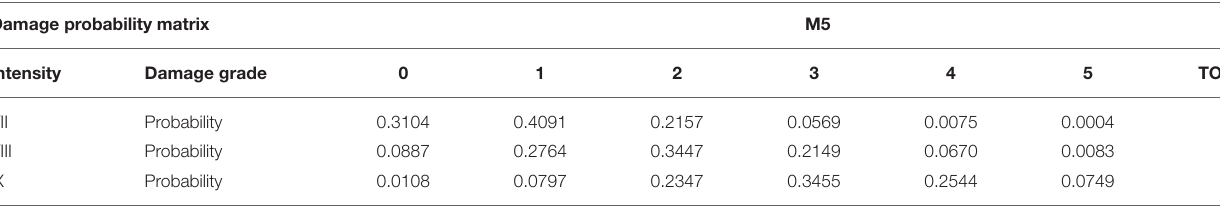
TABLE 3 | Damage probability matrix for M5. Damage probability